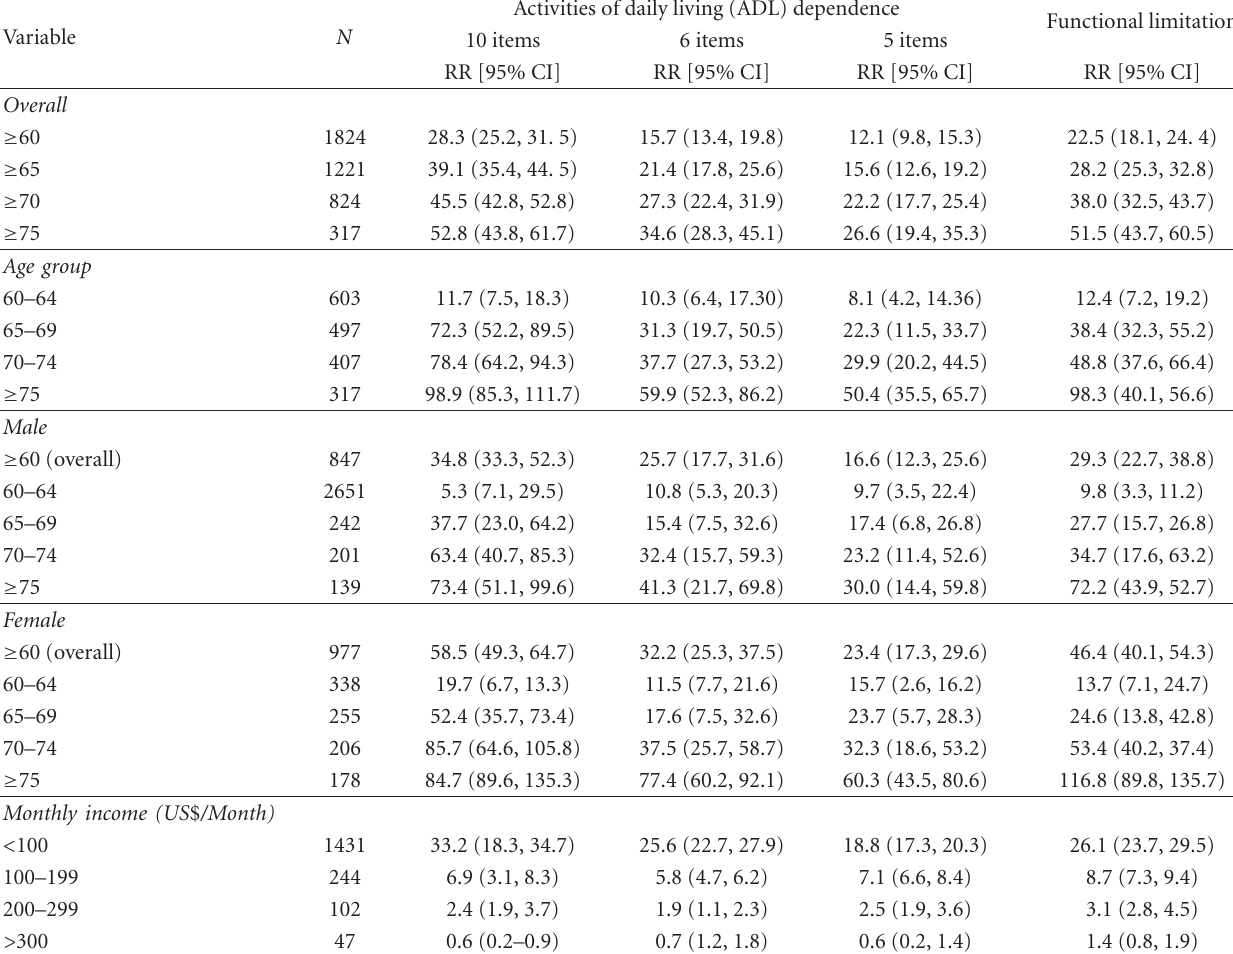
Table 2: Prevalence of physical disability and functional limitation among elderly Nigerian ( n = 1824). Activities of daily living (ADL) Variable N